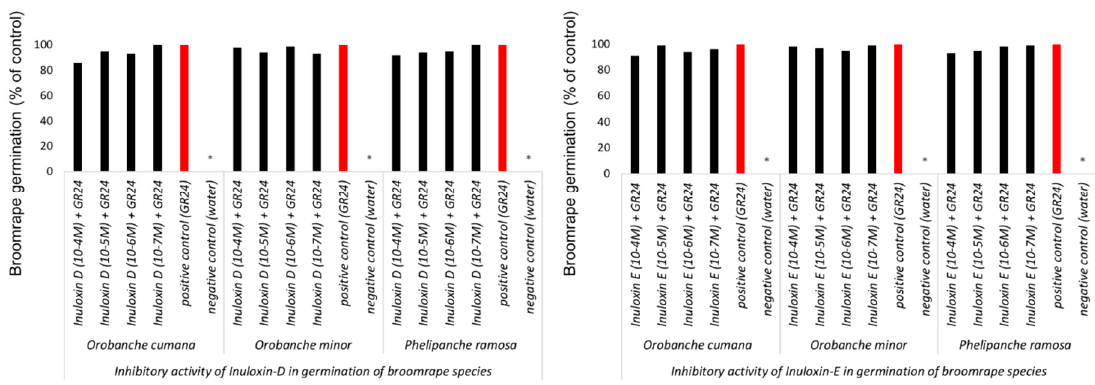
Figure 4. Inhibition of Orobanche cumana , Orobanche minor , and Phelipanche ramosa germination tested by the application of GR24 alone or GR24 mixed with inuloxin D (left panel) and inuloxin E (right panel). Data is expressed as the percentage referred to as the control GR24. The asterisk (*) indicates the differences at the 0.05 level compared with the positive control (seeds induced to germinate with only GR24).